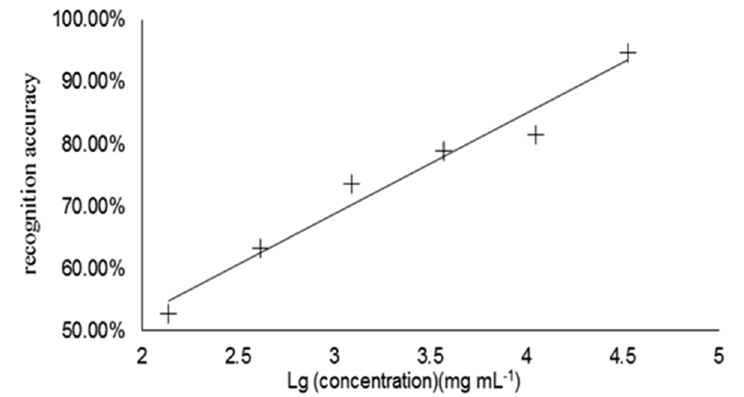
Figure 3. Scatter diagram by CF for determination of propyl lactate detection threshold. The X-axis represents the concentration of propyl lactate to the base 10 logarithm (X = LogA) and Y-axis is the correct recognition ratio, which is the ratio of the correct recognition numbers (cid:2898)(cid:4666)(cid:2913)(cid:2925)(cid:2928)(cid:2928)(cid:2915)(cid:2913)(cid:2930)(cid:4667) in total recognition numbers (cid:4666)Y (cid:3404) (cid:4667) (cid:2898)(cid:4666)(cid:2930)(cid:2925)(cid:2930)(cid:2911)(cid:2922)(cid:2922)(cid:4667)